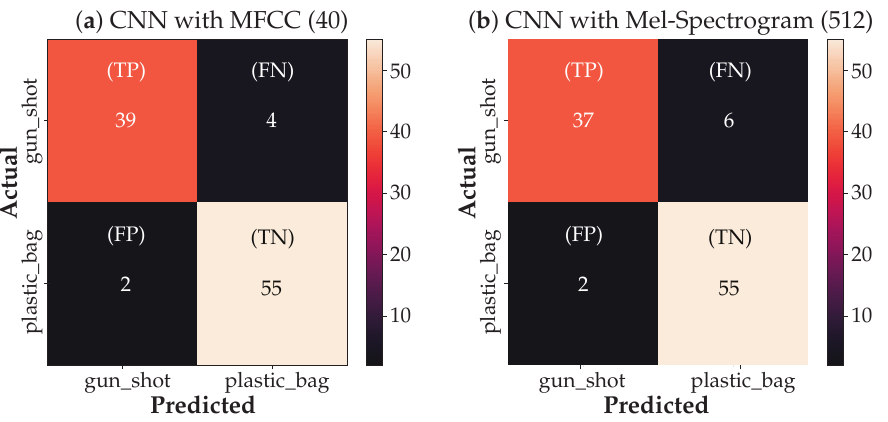
Figure 9. Normalized Confusion Matrix with: ( a ) 40 MFCC Coefficients and ( b ) Mel-spectrogram with FFT window =